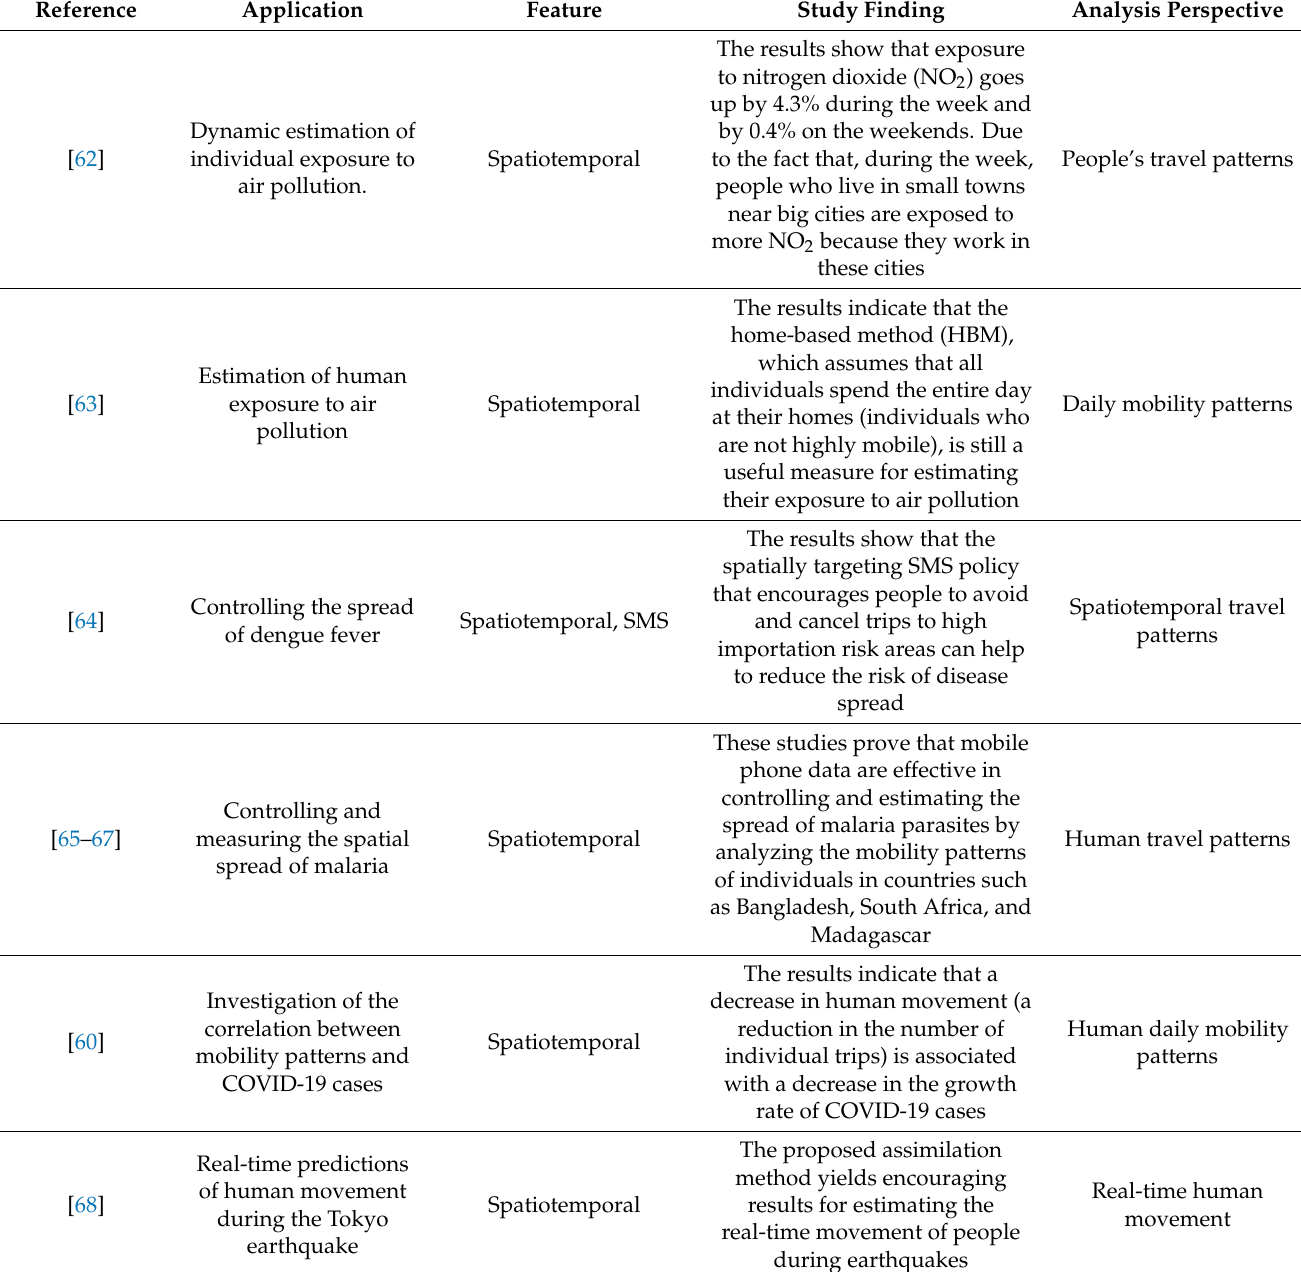
Table 3. List of applications used in public